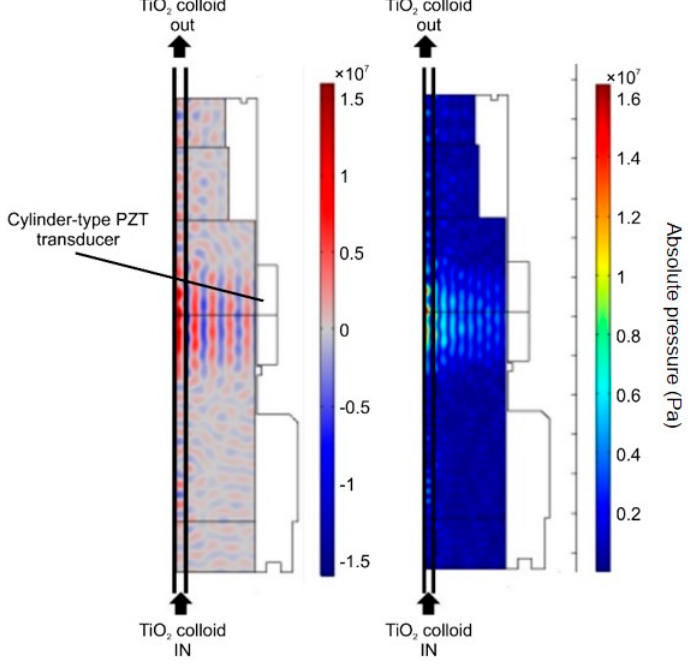
Figure 3. Sound pressure ( left ) and energy ( right ) distribution models of the focused ultrasound radiation.